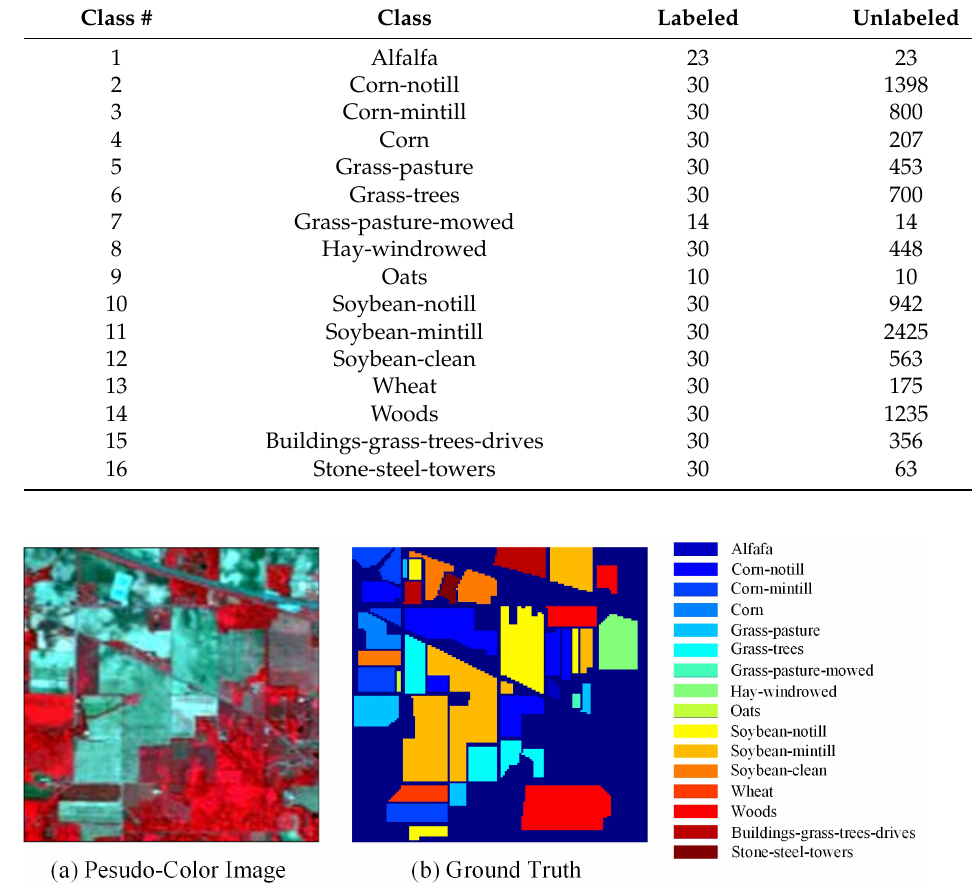
Figure 2. Indian Pines dataset. ( a ) Pseudo-color image. ( b ) Ground truth.